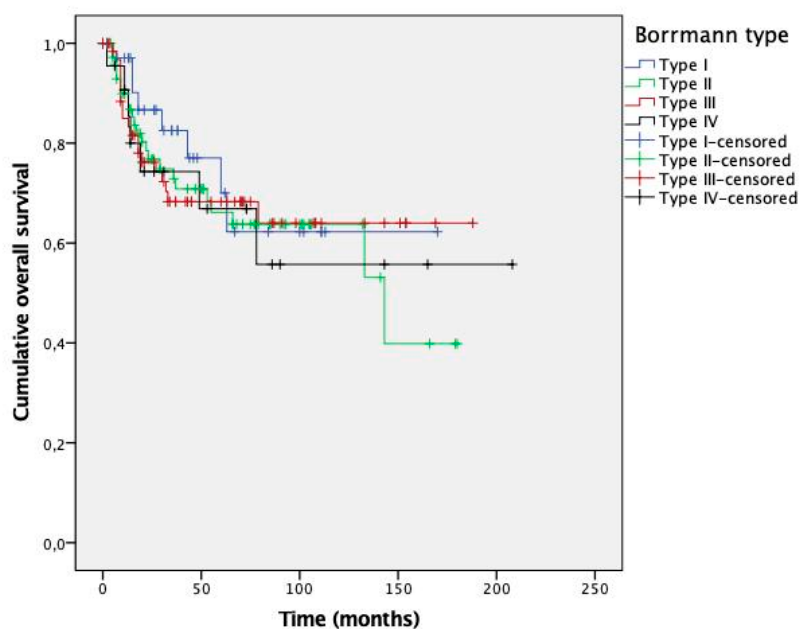
Figure 3. Kaplan–Meier curves for overall survival according to Borrmann type. The p -value by log-rank test was 0.895. Table 6. Mean disease-free and overall survival times according to Borrmann type.